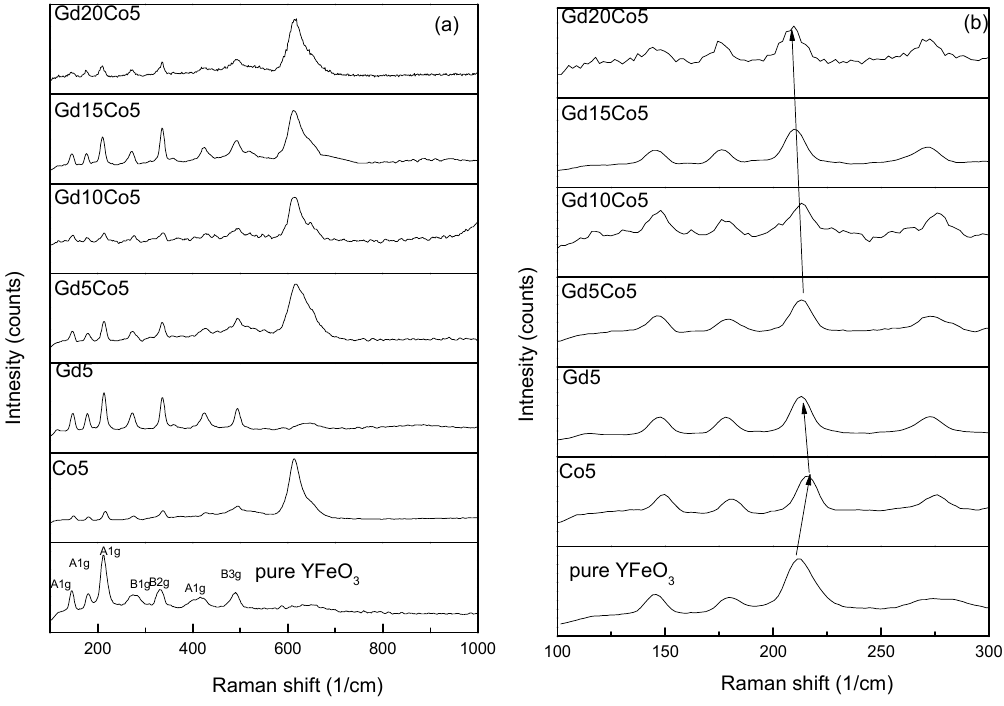
Figure 3. ( a ) Raman spectra of as-prepared nanoparticles. ( b ) The magnified patterns of 221 cm − 1 .